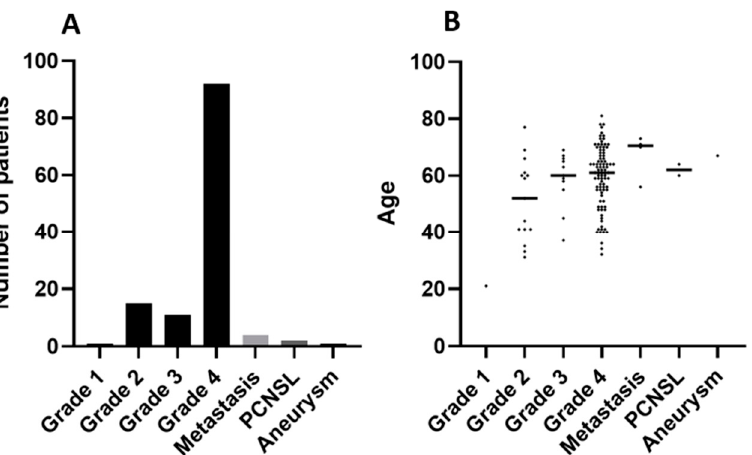
Figure 1. Summary of the patient cohort. ( A ) Numbers of specific tumor samples; ( B ) distribution of patients by age.